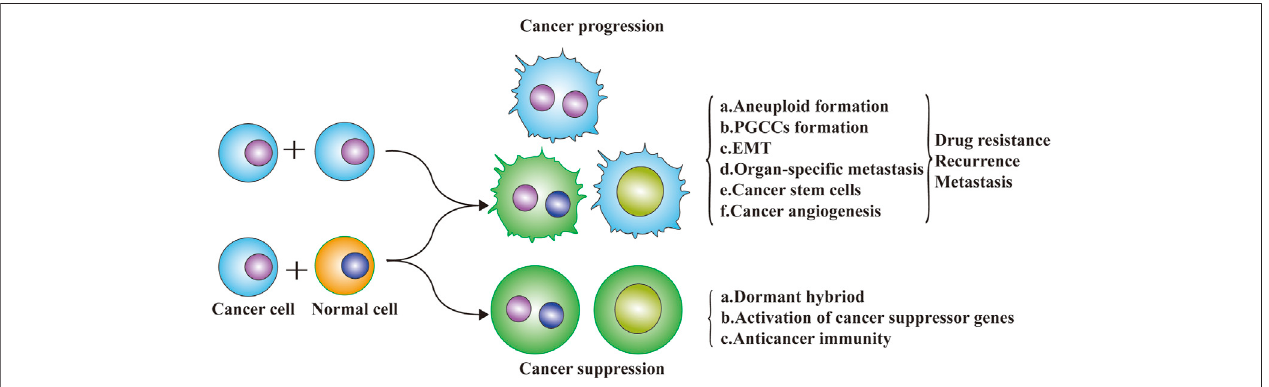
FIGURE 3 | Cell fusion and cancer progression. Cell fusion is a two-edge sword that occurs during the development and progression of cancer. The exchange of DNAbetweencancercellsandnon-cancercells via cellfusionmayresultinadifferentfateofcancercells.Metastaticpotentialgenesfrommacrophages(orcancercells) to cancer cells may enhance the migration and invasive abilities. Tumor suppressor genes exchanged from normal cells to cancer cells may inhibit the malignant progression of cancer